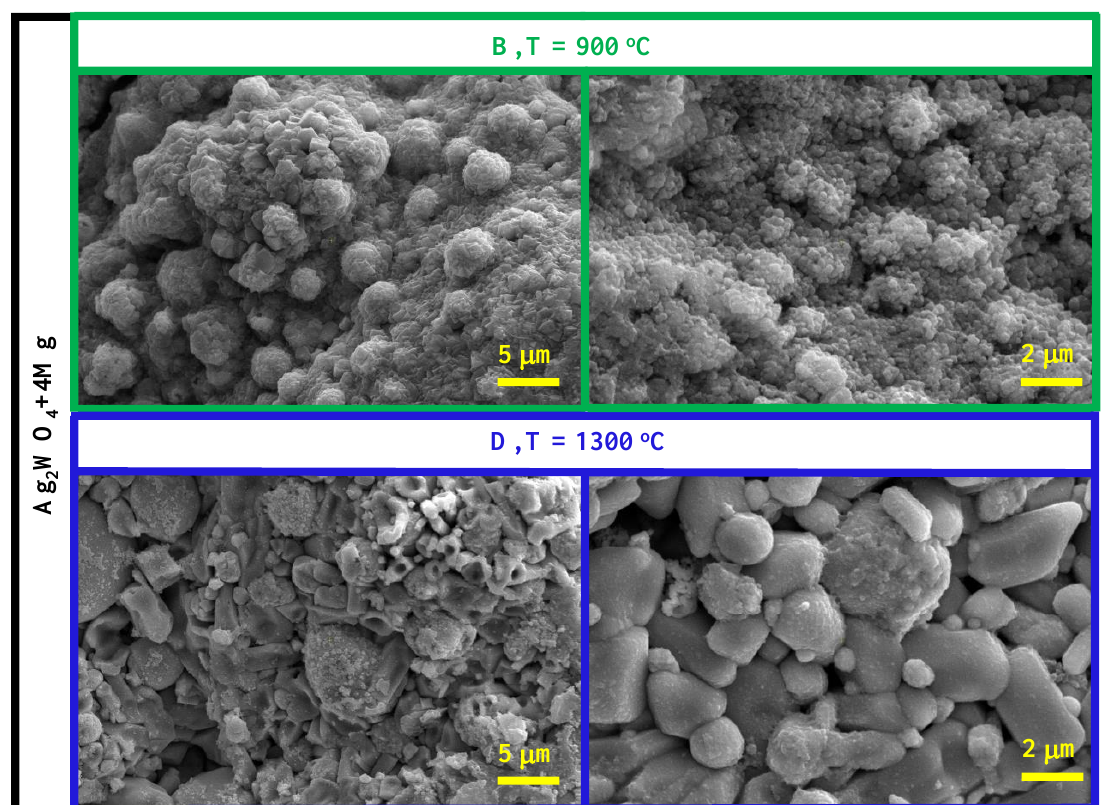
Figure 3. SEM images of the quenched samples for the Ag 2 WO 4 + 4Mg mixture. Compared to low heating rates, β = 5 − 20 ◦ C min − 1 [34], where the interaction starts with a solid + solid mechanism and ends with a liquid + liquid one, in this case, the process began with molten magnesium and silver tungstate. As was foreseeable, with the increasing of the heating rate (from 100 to 1200 °C min −1 ) the exothermic interaction shifted to a higher temperature area (Figure 4a). Based on the data of the maximum deviation temperatures of the exothermic effect at different heating rates, the Kissinger Equation (1) was used to calculate the effective activation energy value for the Ag 2 WO 4 + 4Mg reaction: 119 ± 13 kJ mol − 1 (Figure 4b).